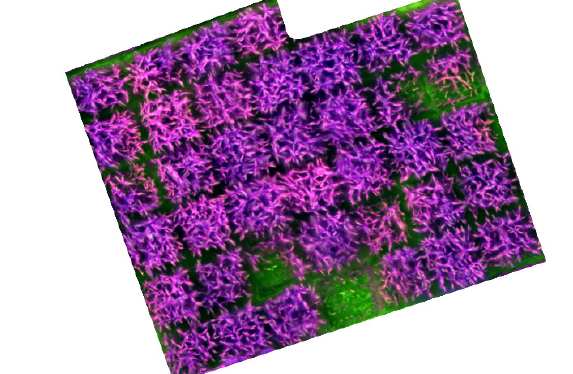
Figure 3. Multispectral image of experimental